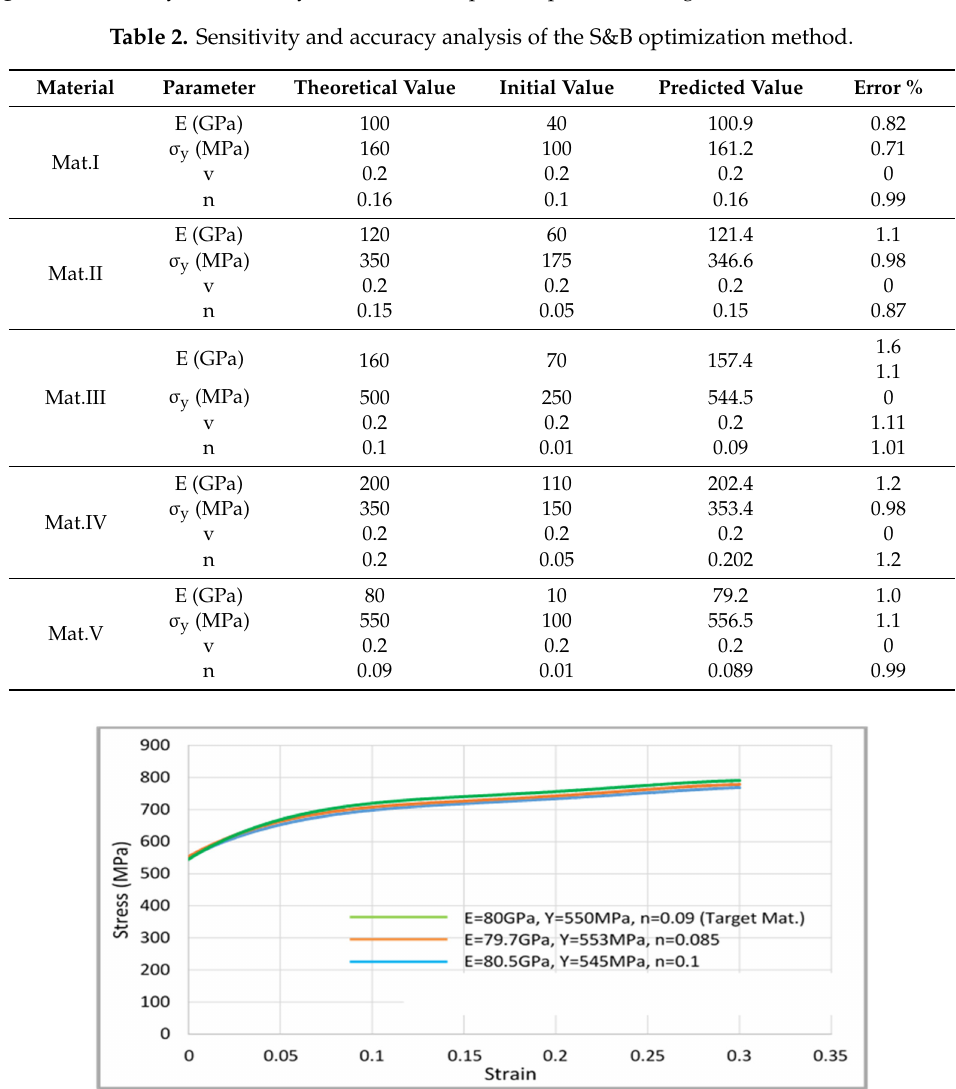
Figure 7. True stress-strain curves of target material and other data with objective function ≤ 0. 01.